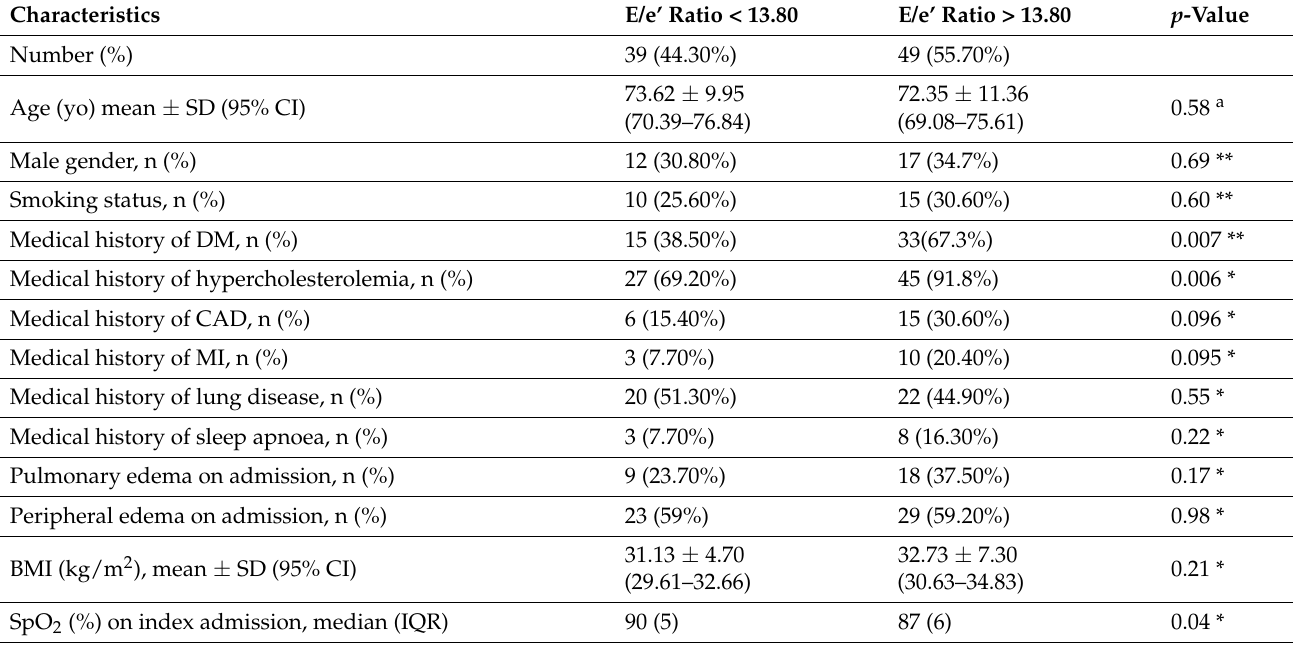
Table 2. Key baseline clinical, biological and echocardiographic characteristics at admission in the two groups. Clinical outcomes, HFR and all-cause mortality in the two groups. Characteristics